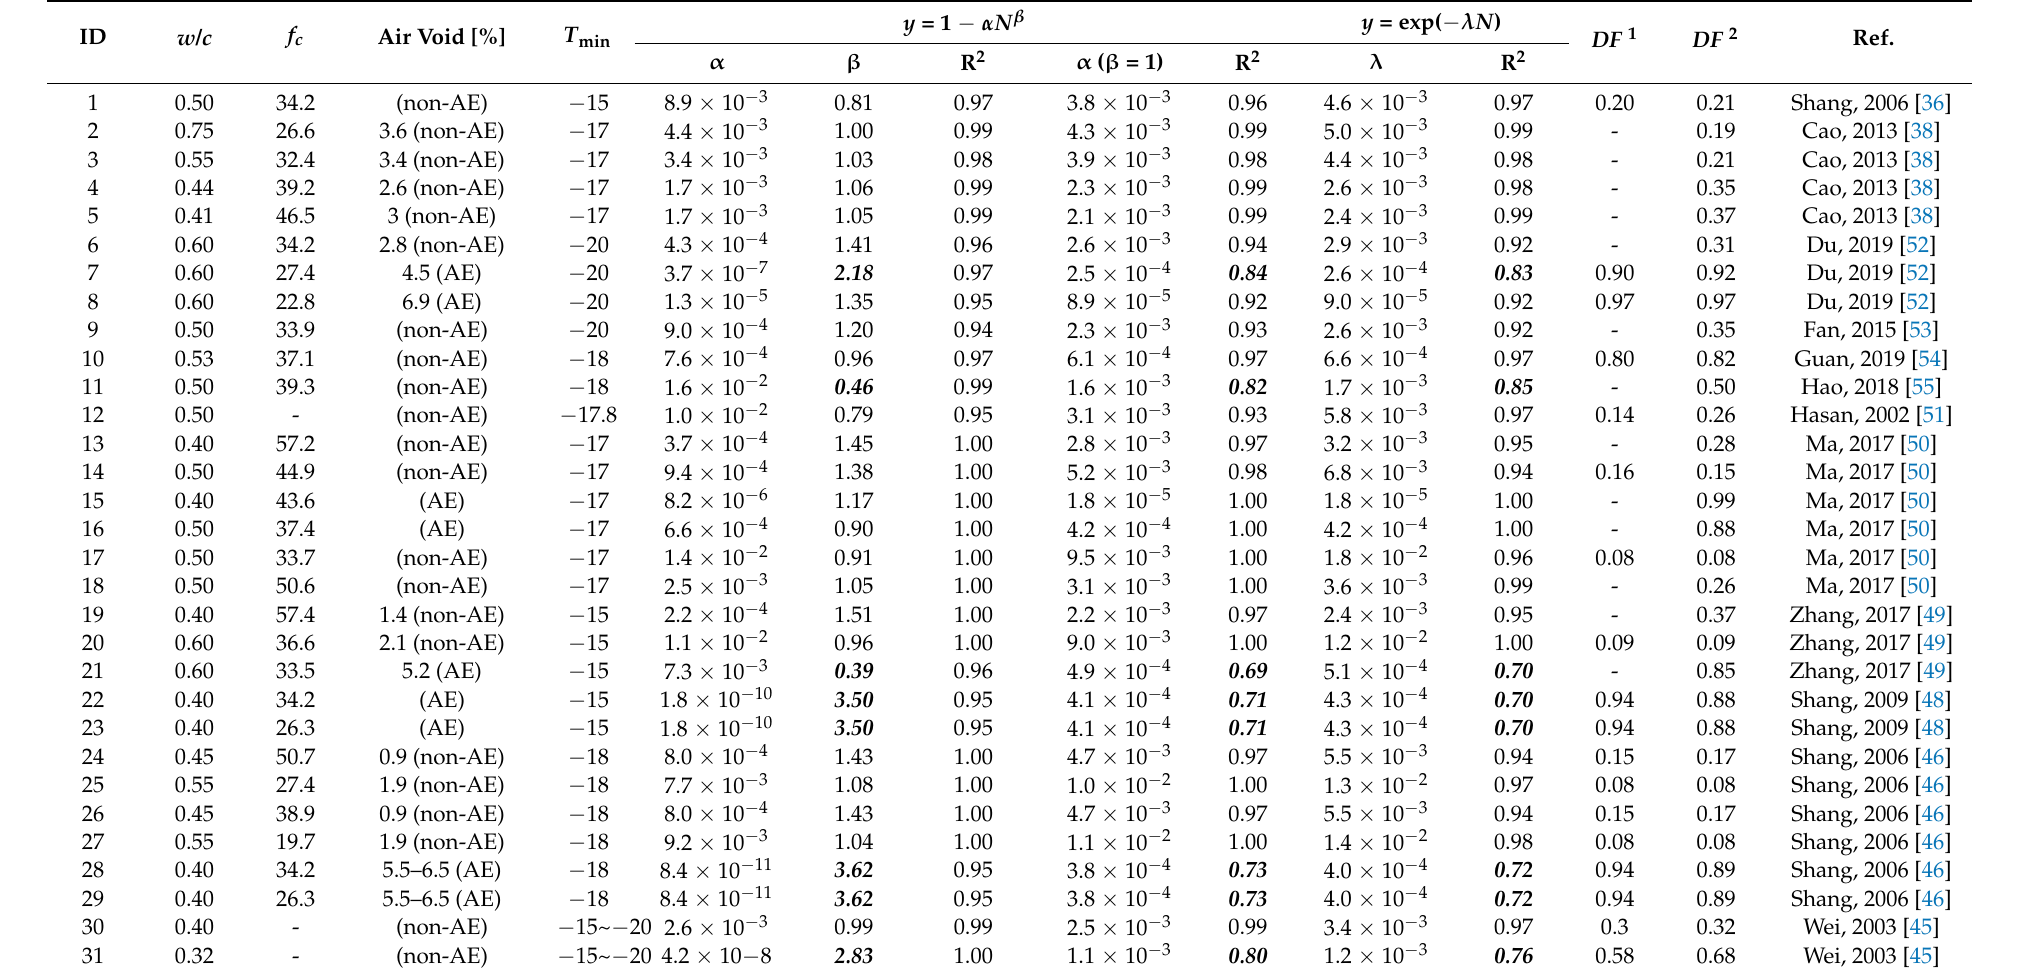
Table A1. Selected data of RDEM during FTC and the regression in terms of cycles